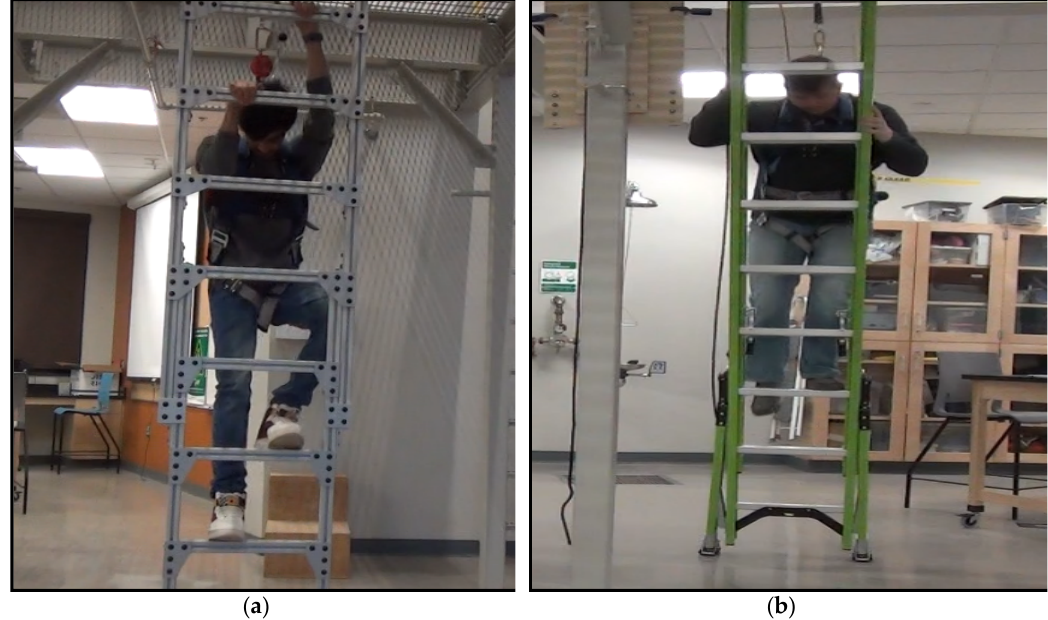
Figure 3. View of video camera: ( a ) fixed ladder climbing, ( b ) extension ladder descending.